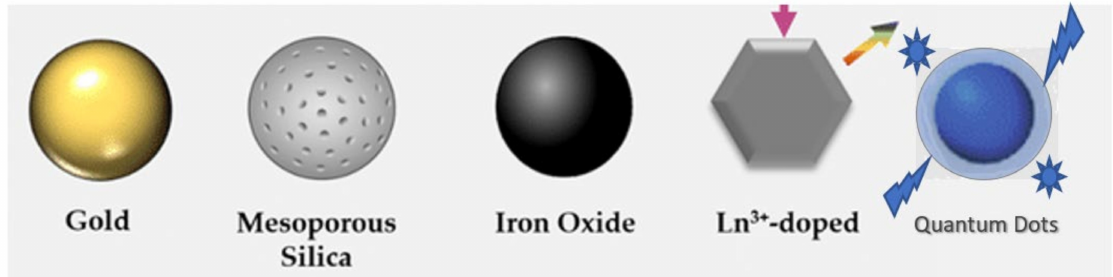
Figure 1. Commonly used inorganic nanoparticles to reinforced polymer